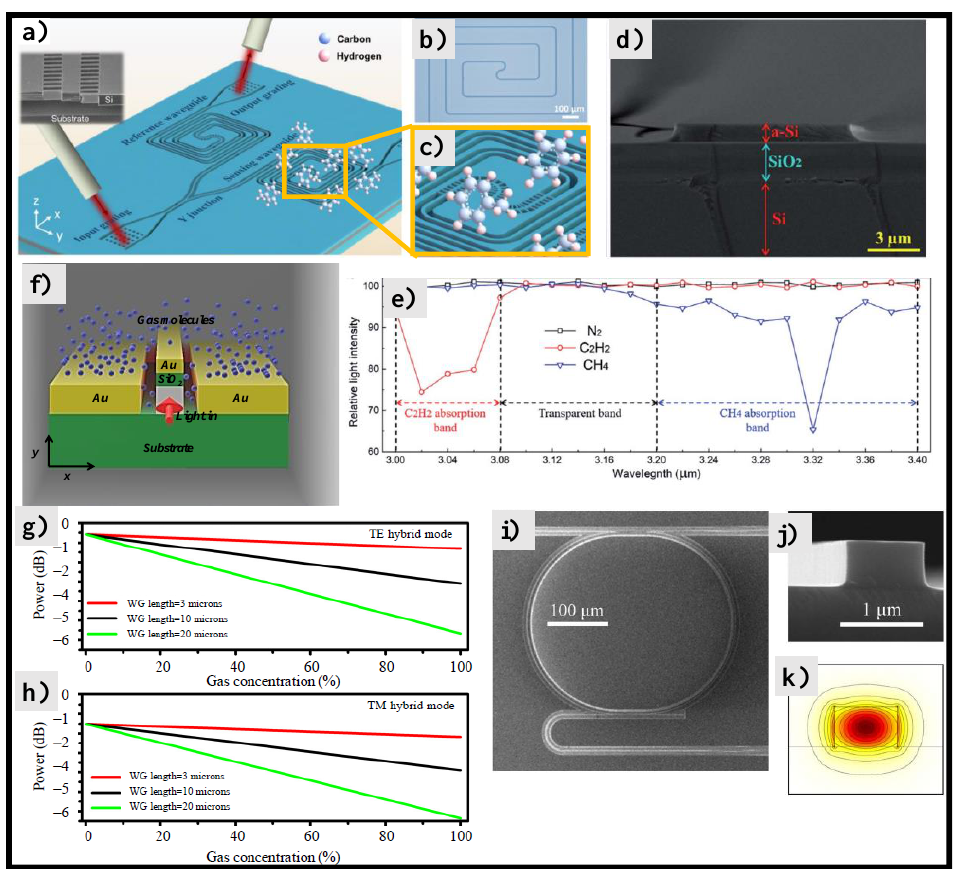
Figure 9. Si-MIR sensing devices, ( a ) suspended Si-WG gas sensing platform, which includes grating couplers, tapers, a power splitter (Y-junction), and spiral WGs, is depicted schematically. Inset: a cross-sectional view of the WG taken using an SEM [9], ( b ) optical picture of the Si spiral WG floating in mid-air [9], ( c ) a zoomed-in image of the sensing WG encircled by toluene molecules, as shown in Figure 8a by the yellow square box [9], ( d ) SEM photo of the Si WG [168], ( e ) when N 2 , C 2 H 2 , and CH 4 were used, the WG mode intensities were measured. C 2 H 2 showed strong intensity attenuation between λ = 3 μm and 3.08 μm, while CH 4 showed strong intensity attenuation between λ = 3.29 μm and 3.33 μm [168], ( f ) HPWG enclosed in a gas sensor cell [169], ( g ) TE hybrid mode power variation vs. gas concentration [169], ( h ) TM hybrid mode power variation vs. gas concentration [169], ( i ) SEM picture of a racetrack RR [162], ( j ) WG cross-section as seen using an SEM [162], ( k ) FEM-calculated E-field mode profile of the matching quasi-TE mode [162].